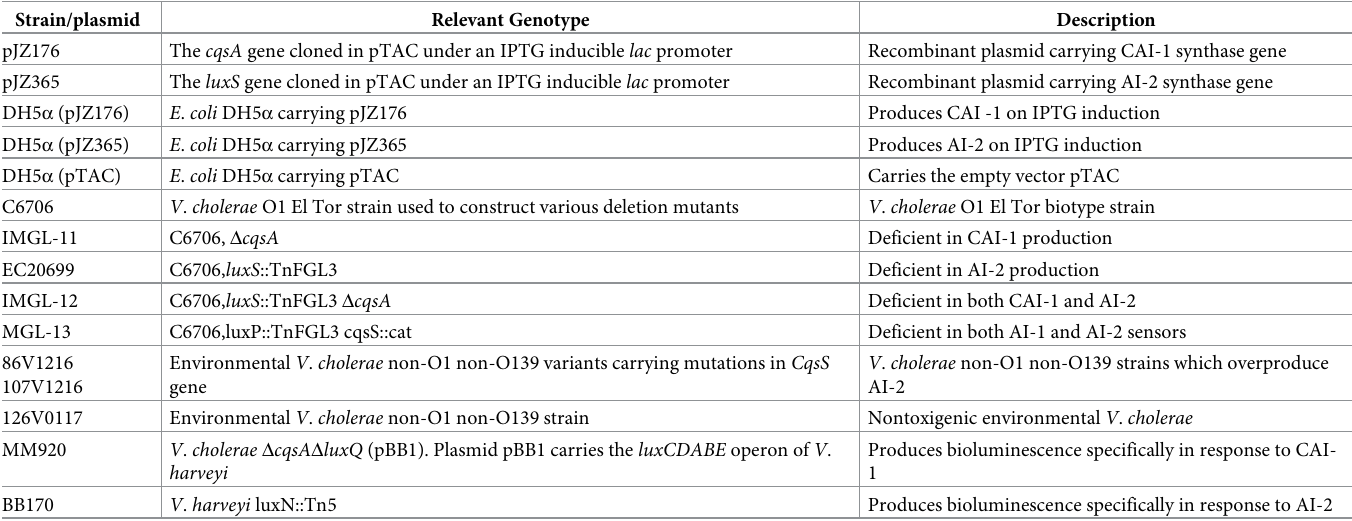
Table 1. Description of bacterial strains and plasmids included in this study.